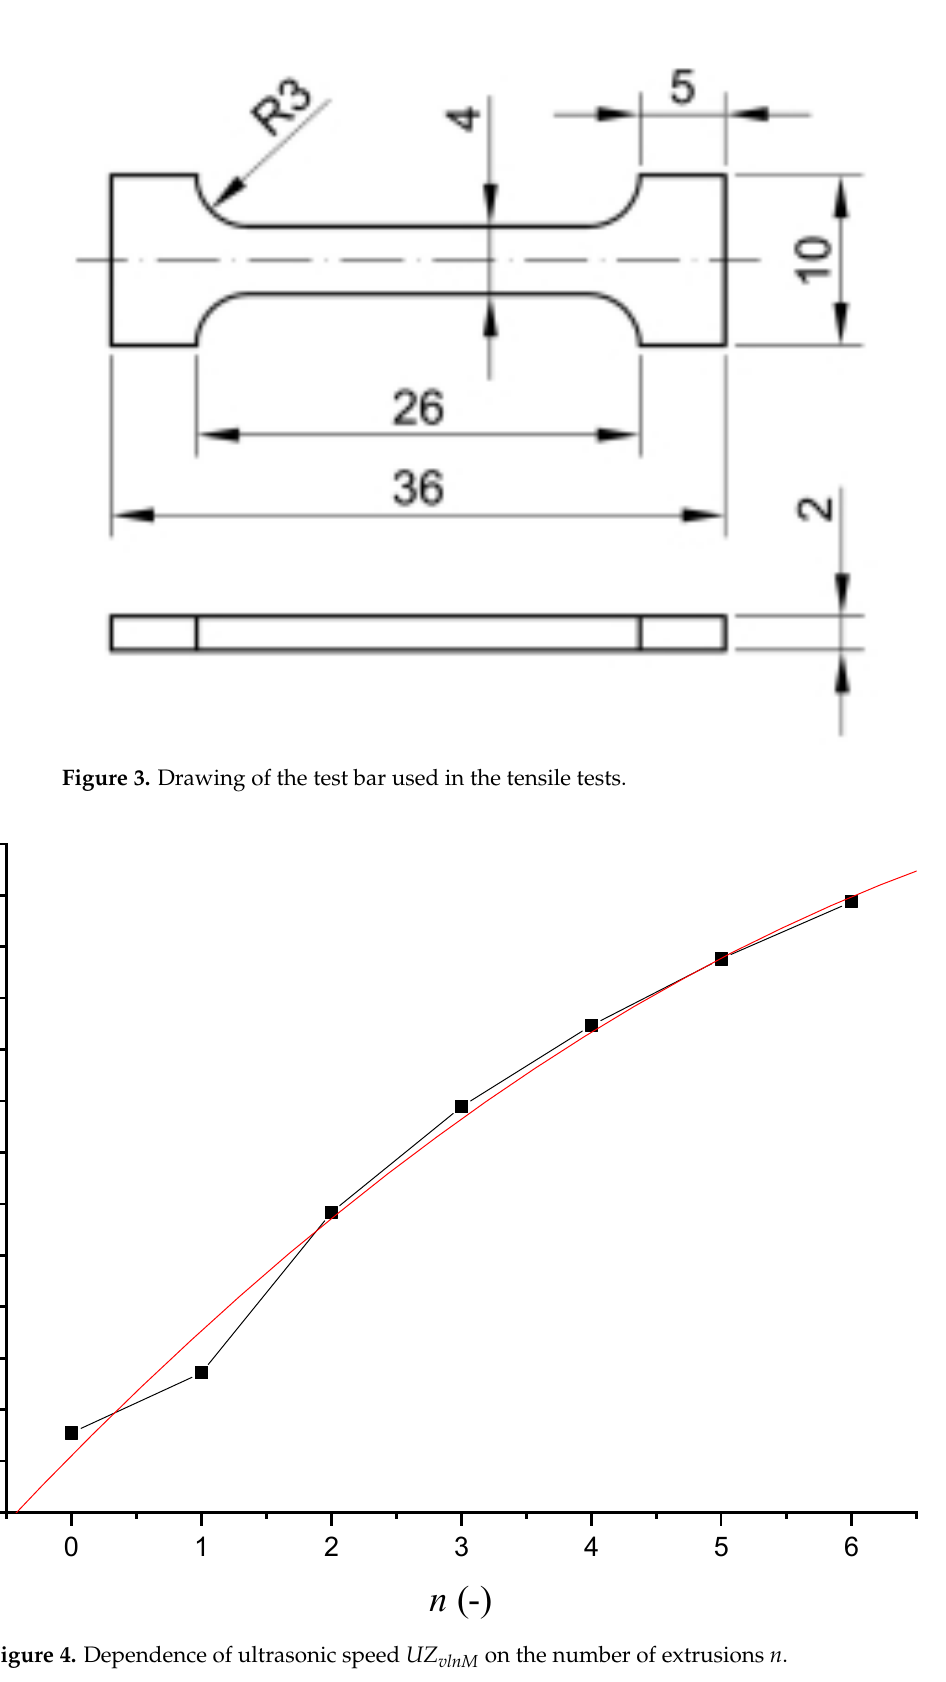
Figure 4. Dependence of ultrasonic speed UZ vlnM on the number of extrusions n .